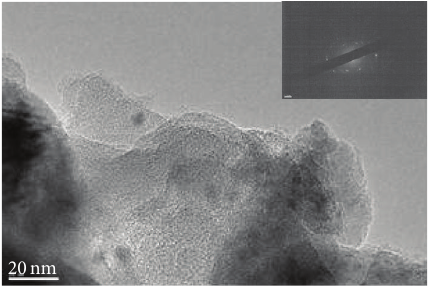
Figure 5: TEM image and SAED of char obtained from mixture of Japanese cedar wood meal/Fe 3 O 4 (1: 1 w/w) pyrolyzed at 800 ∘